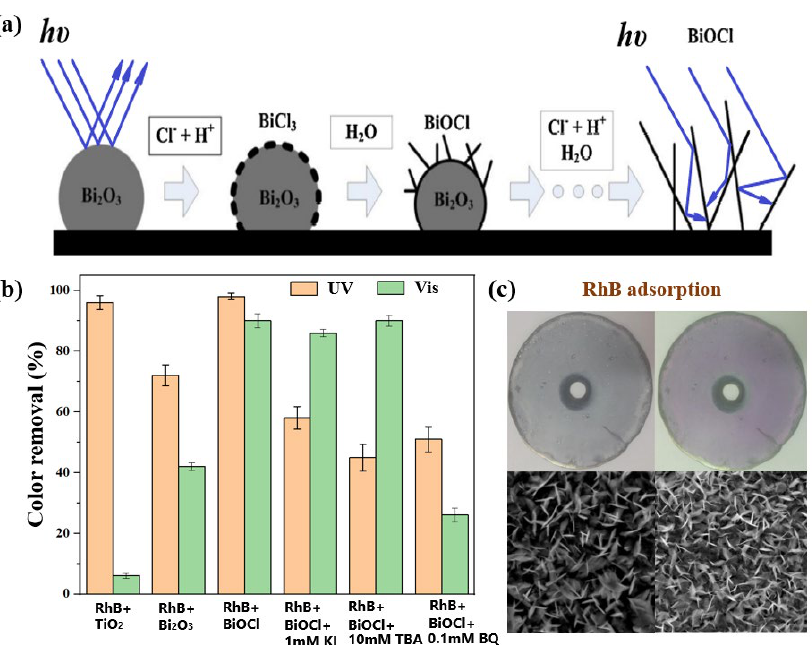
Figure 6. ( a ) Synthesis process of BiOCl and the light reflection on the surface of β -Bi 2 O 3 thin film and BiOCl thin film, ( b ) RhB color removal obtained by different photoanode and the reactive oxygen species detection in the presence of different sacrificial agents, and ( c ) BiOCl-coated disk and BiOCl- coated disk with RhB adsorption and their corresponding SEM images. Reprinted/adapted with permission from Ref. [82]. 2013,